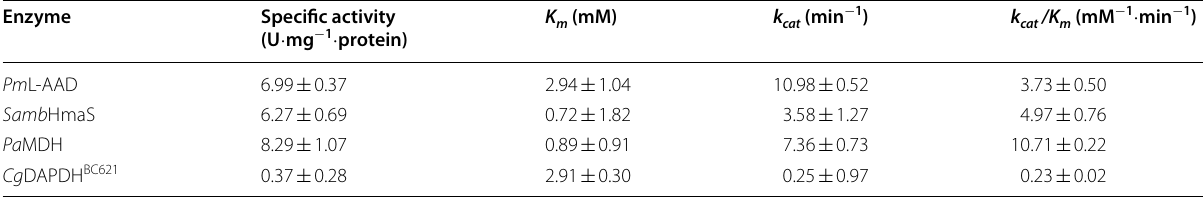
L-AAD: l -amino acid deaminase; HmaS: 4-hydroxymandelate synthase; MDH: ( S )-mandelate dehydrogenase; DAPDH: meso -diaminopimelate dehydrogenase a The specific activity was determined with 10-μM purified enzymes and 10-mM corresponding substrate in 1-mL Tris–HCl buffer (50 mM, pH 8.0) at 30 °C for 15 min b The k cat /K m values was determined with 10-μM purified enzymes and 1–20-mM corresponding substrate in 1-mL Tris–HCl buffer (50 mM, pH 8.0) at 30 °C for 30 min